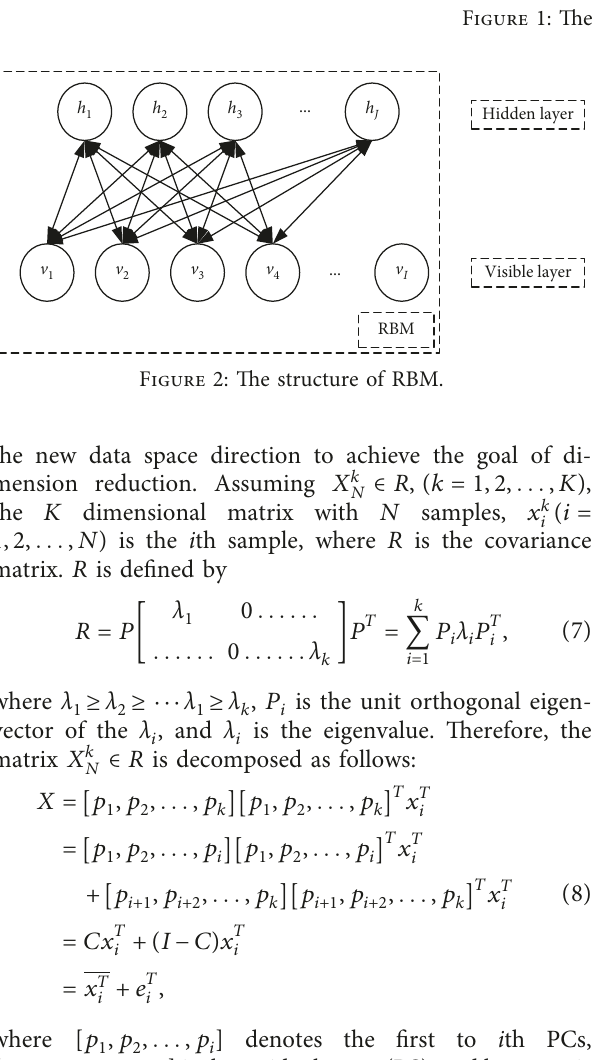
Figure 1: The structure of DBN.